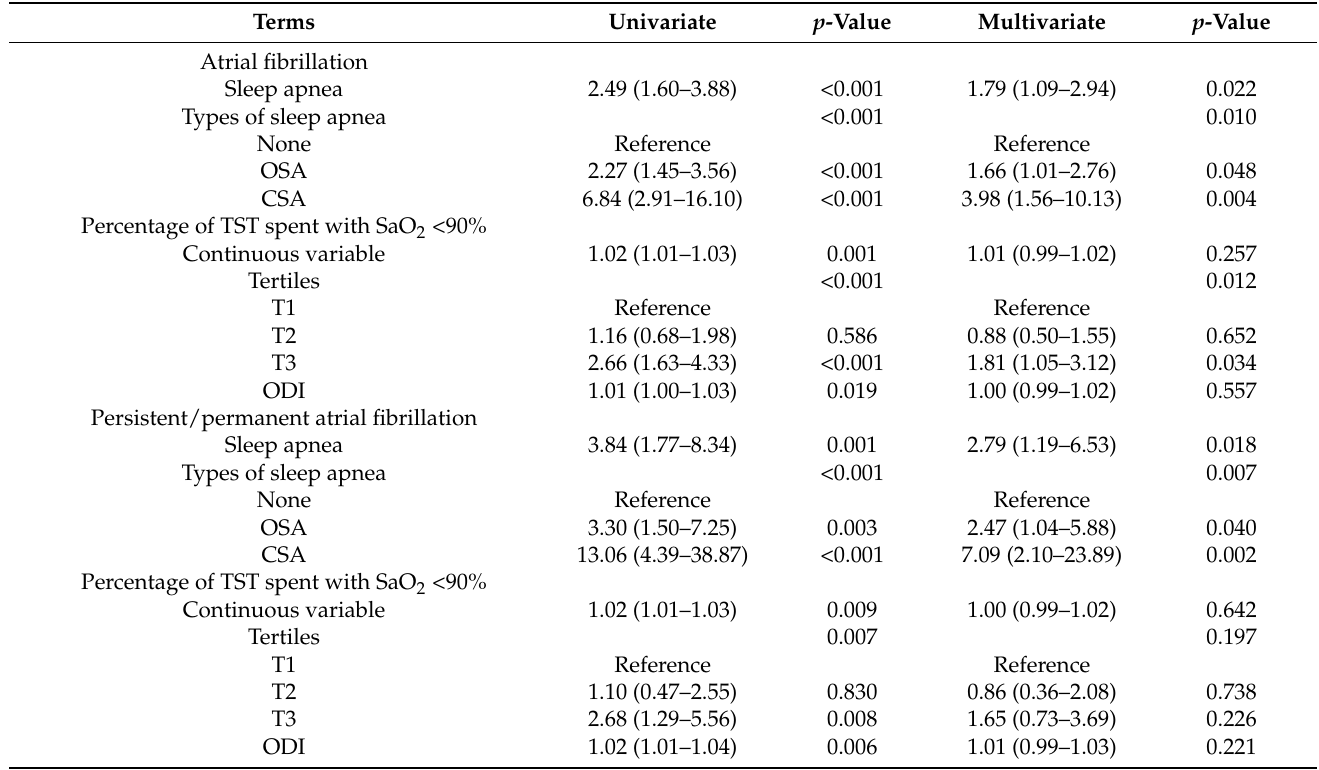
Table 4. Association of types of sleep apnea and nocturnal hypoxemia with AF in patients with